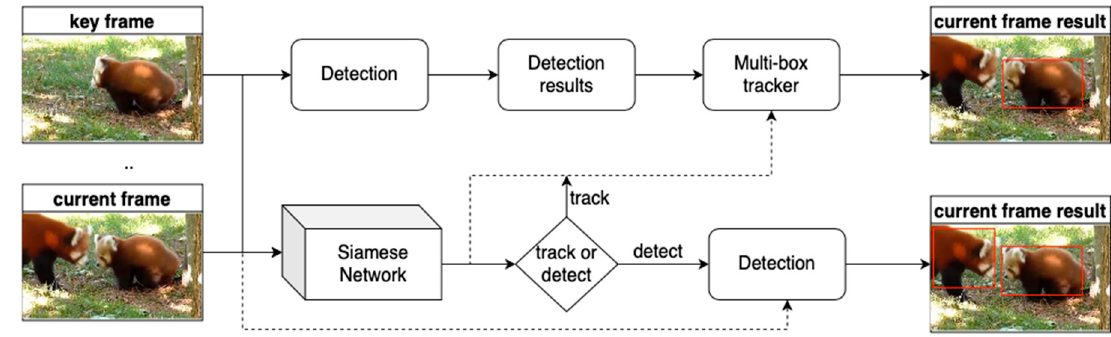
Figure 9. D or T framework [80].